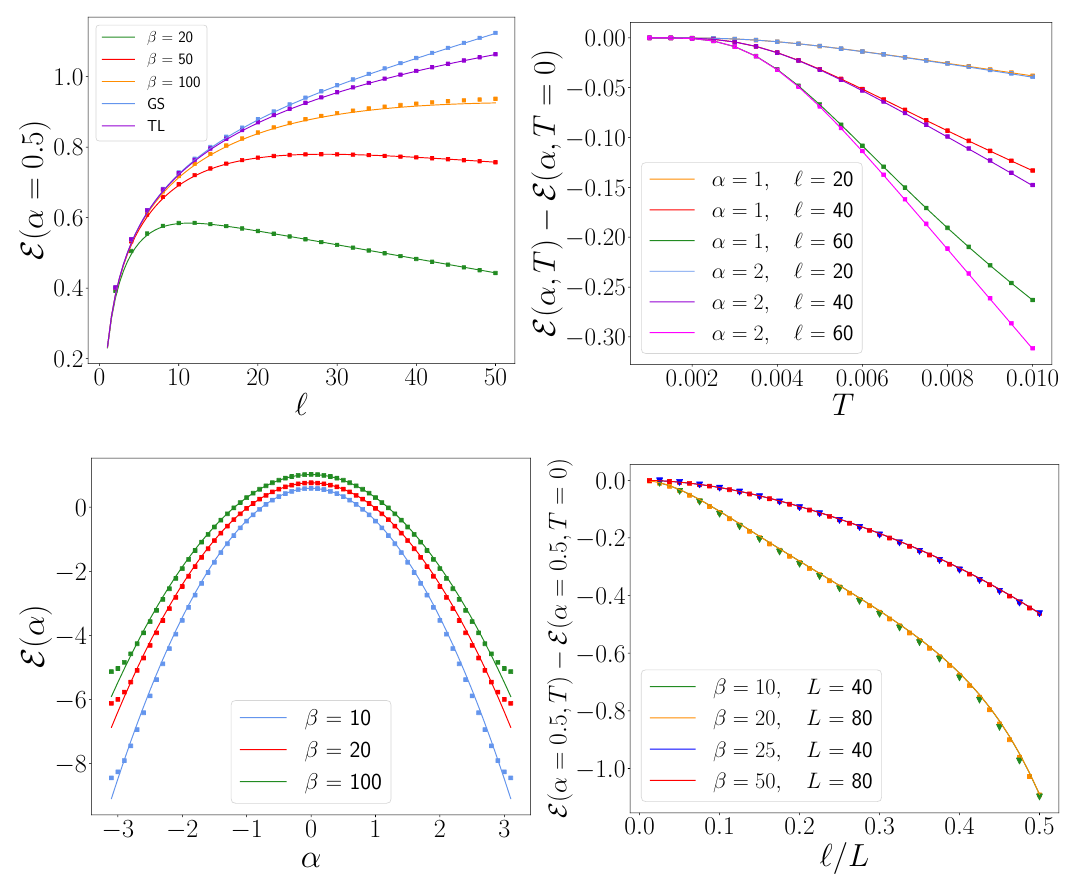
( α ) in a tripartite torus with subsystem length Figure 2: Charged negativity E (cid:96) = (cid:96) = (cid:96) . CFT results (85), lines, against numerics on the lattice, symbols. Top- 1 2 ( α ) as a function of (cid:96) for α = 0.5. We consider different values of β = 1 / T : left: E in particular, GS stands for ground state, i.e. T = 0 while TL refers to the thermo- dynamic limit T = 0, L → ∞ . System size is fixed to L = 200 sites, except for the ( α ) as a function of the temperature T for different values of TL curve. Top-right: E α and (cid:96) , with L = 200. The subtraction of the value ( α , T = 0 ) cancels the depen- E ( α ) as a dence on the cutoff and the resulting curves are universal. Bottom-left: E function α for L = 200 and (cid:96) = 20 for a few β . The agreement is perfect away from the boundaries α = ± π . Bottom-right: Scaling collapse of the charged negativity as a function of β/ L and (cid:96)/ L . We fix α =